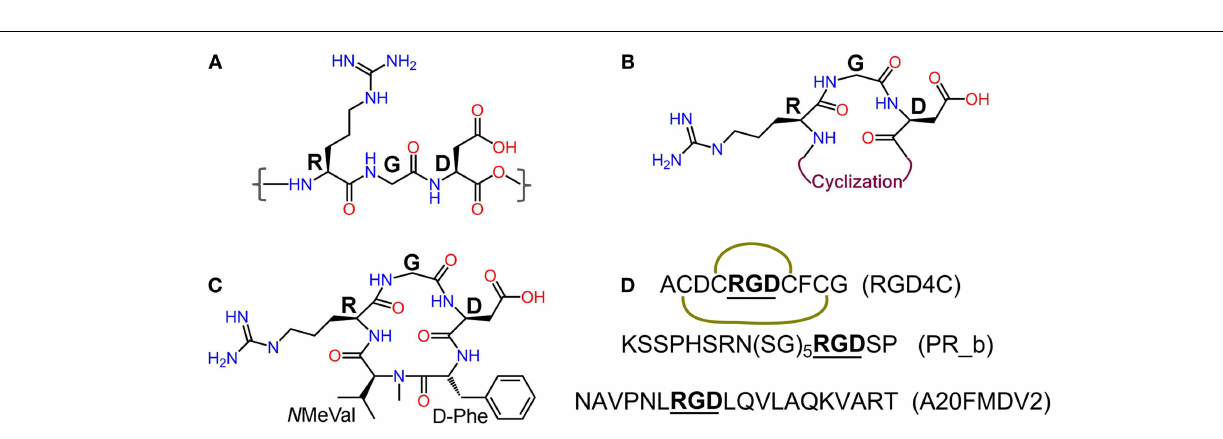
FIGURE 2 | (A) Integrin recognition motif RGD; (B) schematic representation of cyclic RGD ( c RGD); (C) Cilengitide – c (RGDf- N MeVal); (D) peptide sequences of RGD4C (the green curves indicate disulfide bridges), α 5 β 1 ligand PR_b, and α v β 6 ligand